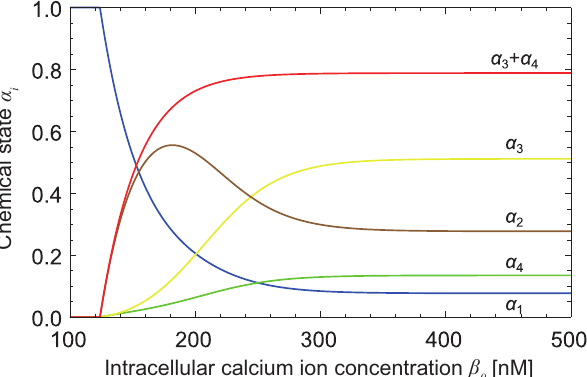
Fig. 4 Relationship between chemical state fractions α 1 , ··· ,α 4 and the intracellular calcium ion concentration β 0 at the chemically steady state.